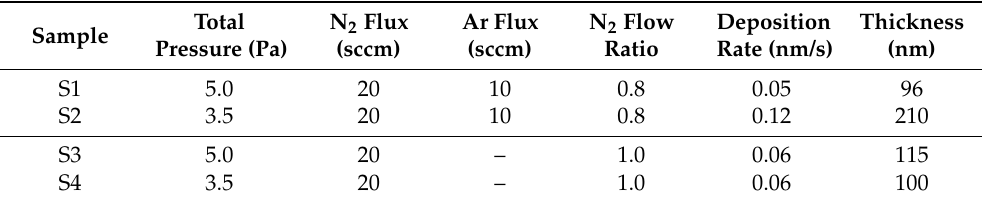
Table 1. Summary of the deposition conditions, the calculated deposition rate, and the measured thickness of the samples under